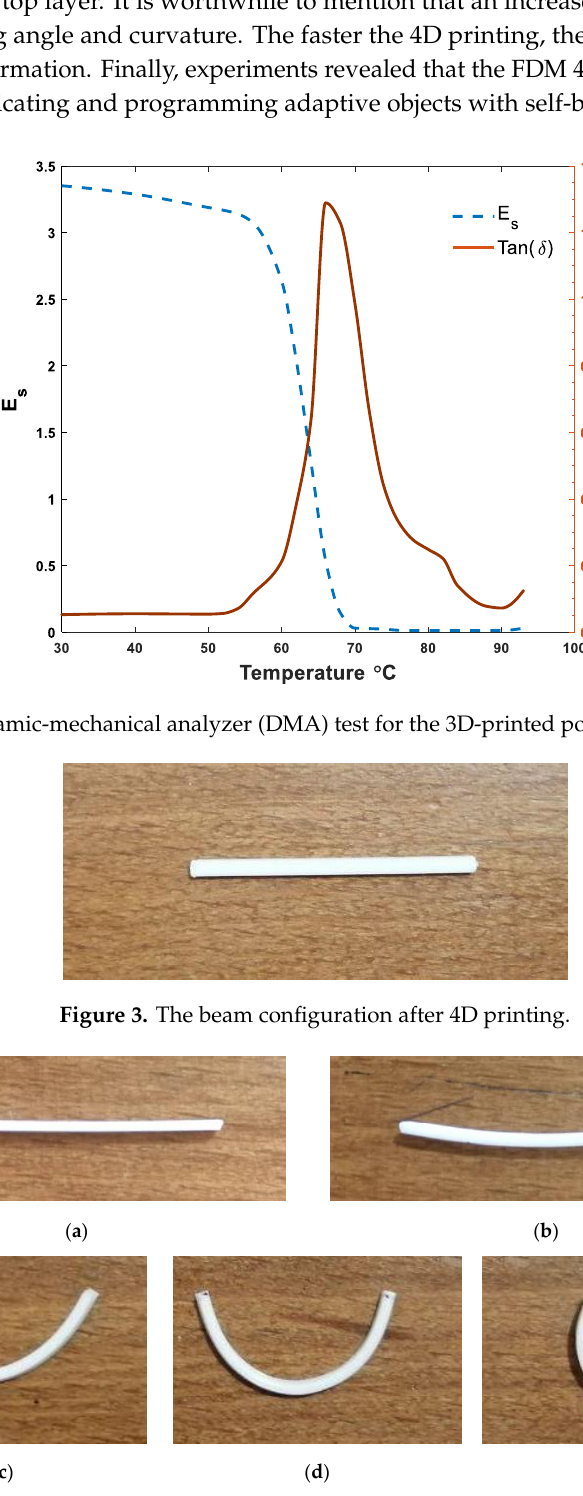
Figure 2. Dynamic-mechanical analyzer (DMA) test for the 3D-printed polylactic acid (PLA).